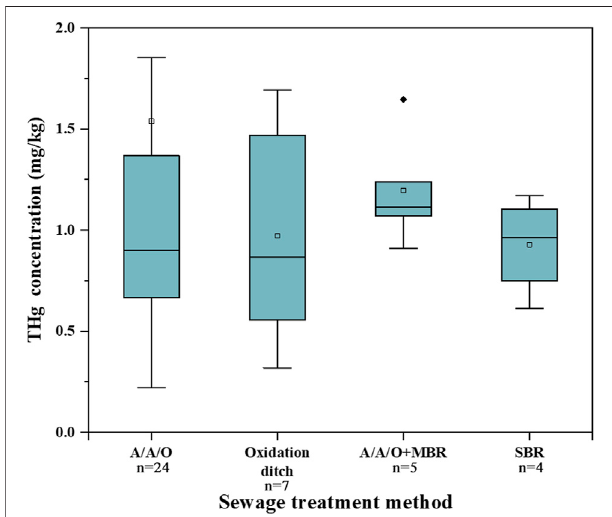
FIGURE 2 | Box-plot of total Hg concentrations (mg/kg, dry weight) of different sewage treatment methods (A/A/O - Anaerobic-Anoxic-Oxic process; MBR - Membrane Bio-Reactor process; SBR - Sequential Batch Reactor process). The bottom and top of the box represent the fi rst and third quartiles (25th and 75th percentile values), the line inside the box represents the second quartile (median), and the open square inside the box represents the average value. The whiskers extend 1.5 interquartile ranges (75th percentile value – 25th percentile value) from each end of the box, and markers (solid diamond) plotted outside each whisker are considered as outliers. FIGURE 3 | Percent of Hg extracted in different fractions during